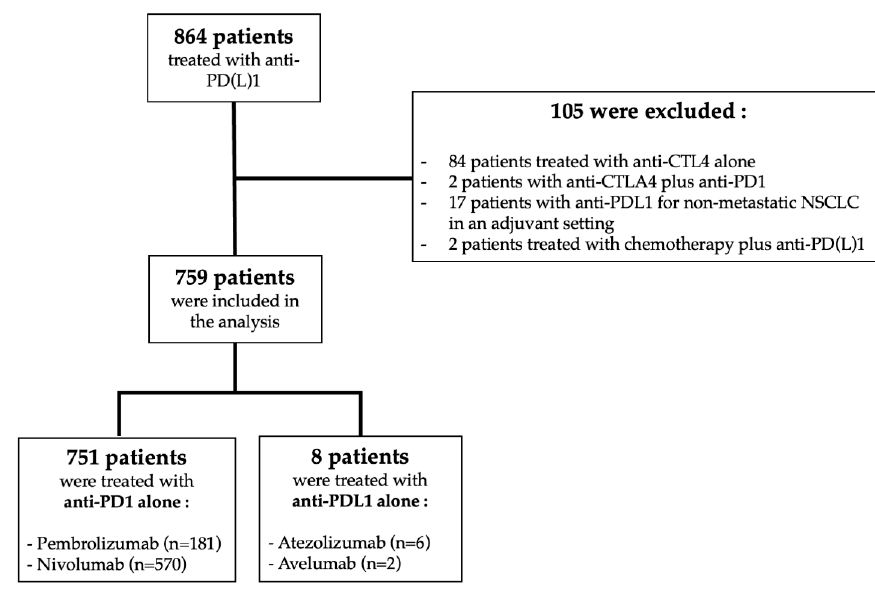
Figure 1. Study flow chart. Table 1. Patient characteristics according to the number of metastatic sites (one MS versus two